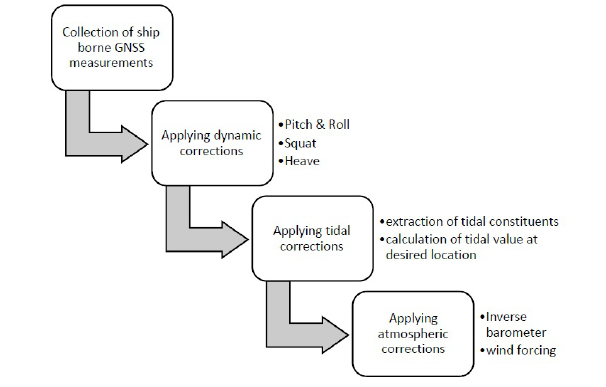
Figure 1: Flow chart of the methodology